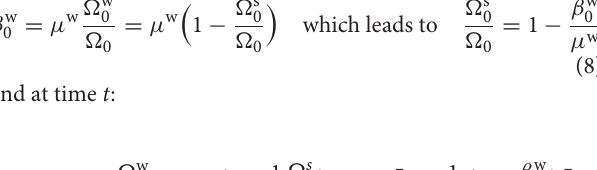
may increase it if the attenuation coefficient of water is higher than the